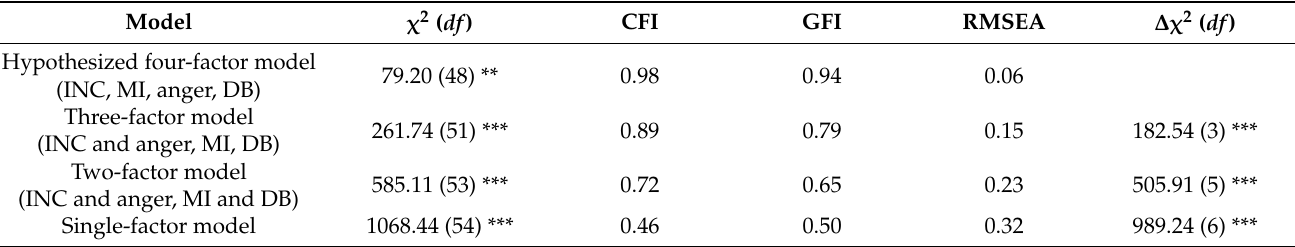
Table 2. Model fit statistics for measurement models.